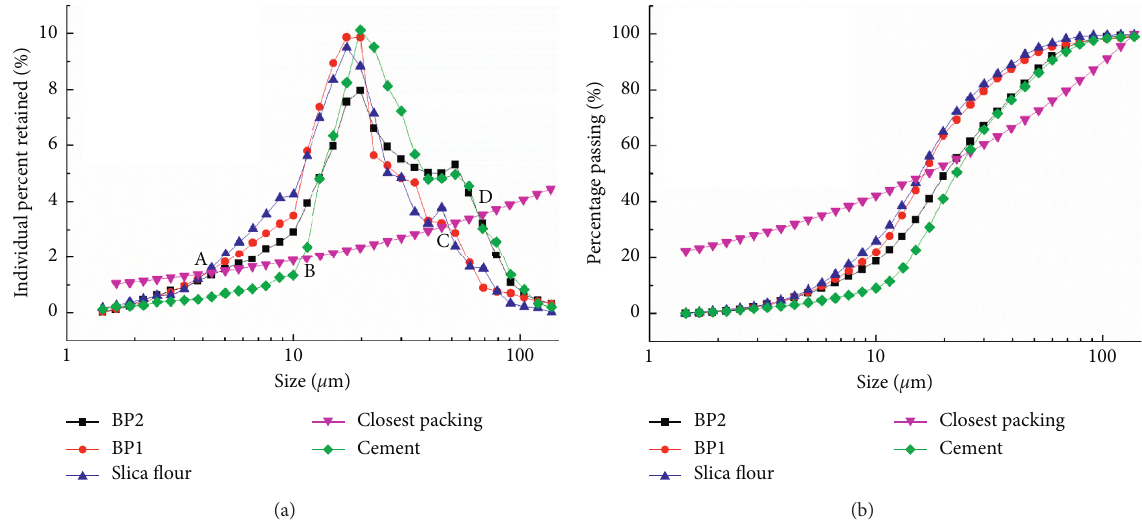
Figure 5: The (a) individual percent retained and (b) percentage passing of different powder materials.